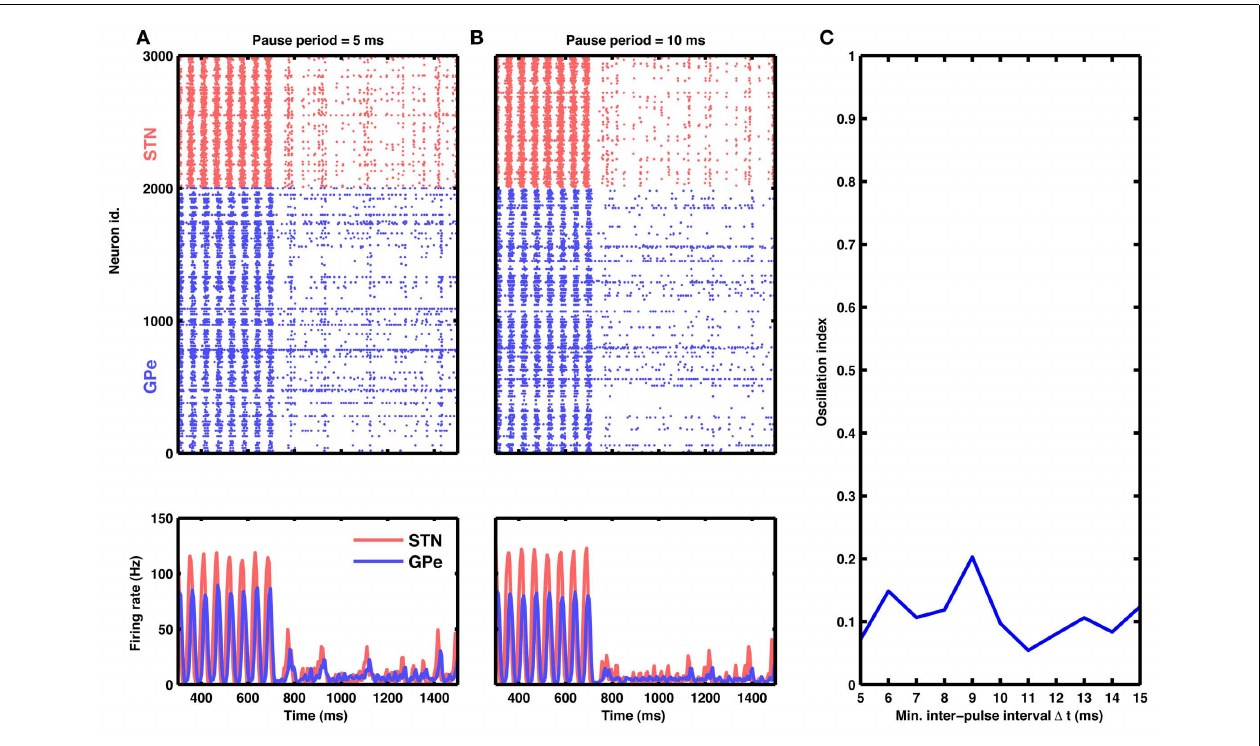
FIGURE 7 |Aperiodic stimulation protocol. (A) Raster of spiking activity (top) and population activity (bottom) in the STN-GPe network for STN (red) and GPe (blue) neurons. At time 750ms, input to STN neurons was blanked aperiodically for 10ms. Successive inter-pulse intervals were chosen randomly from a finite set of possible values: 5, 10, and 15ms